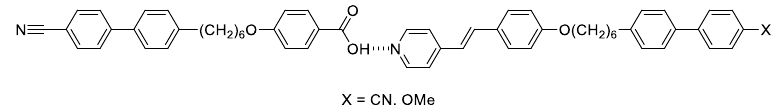
Figure 1. Structure of the CB6OBA:nOS hydrogen-bonded supramolecular dimers.